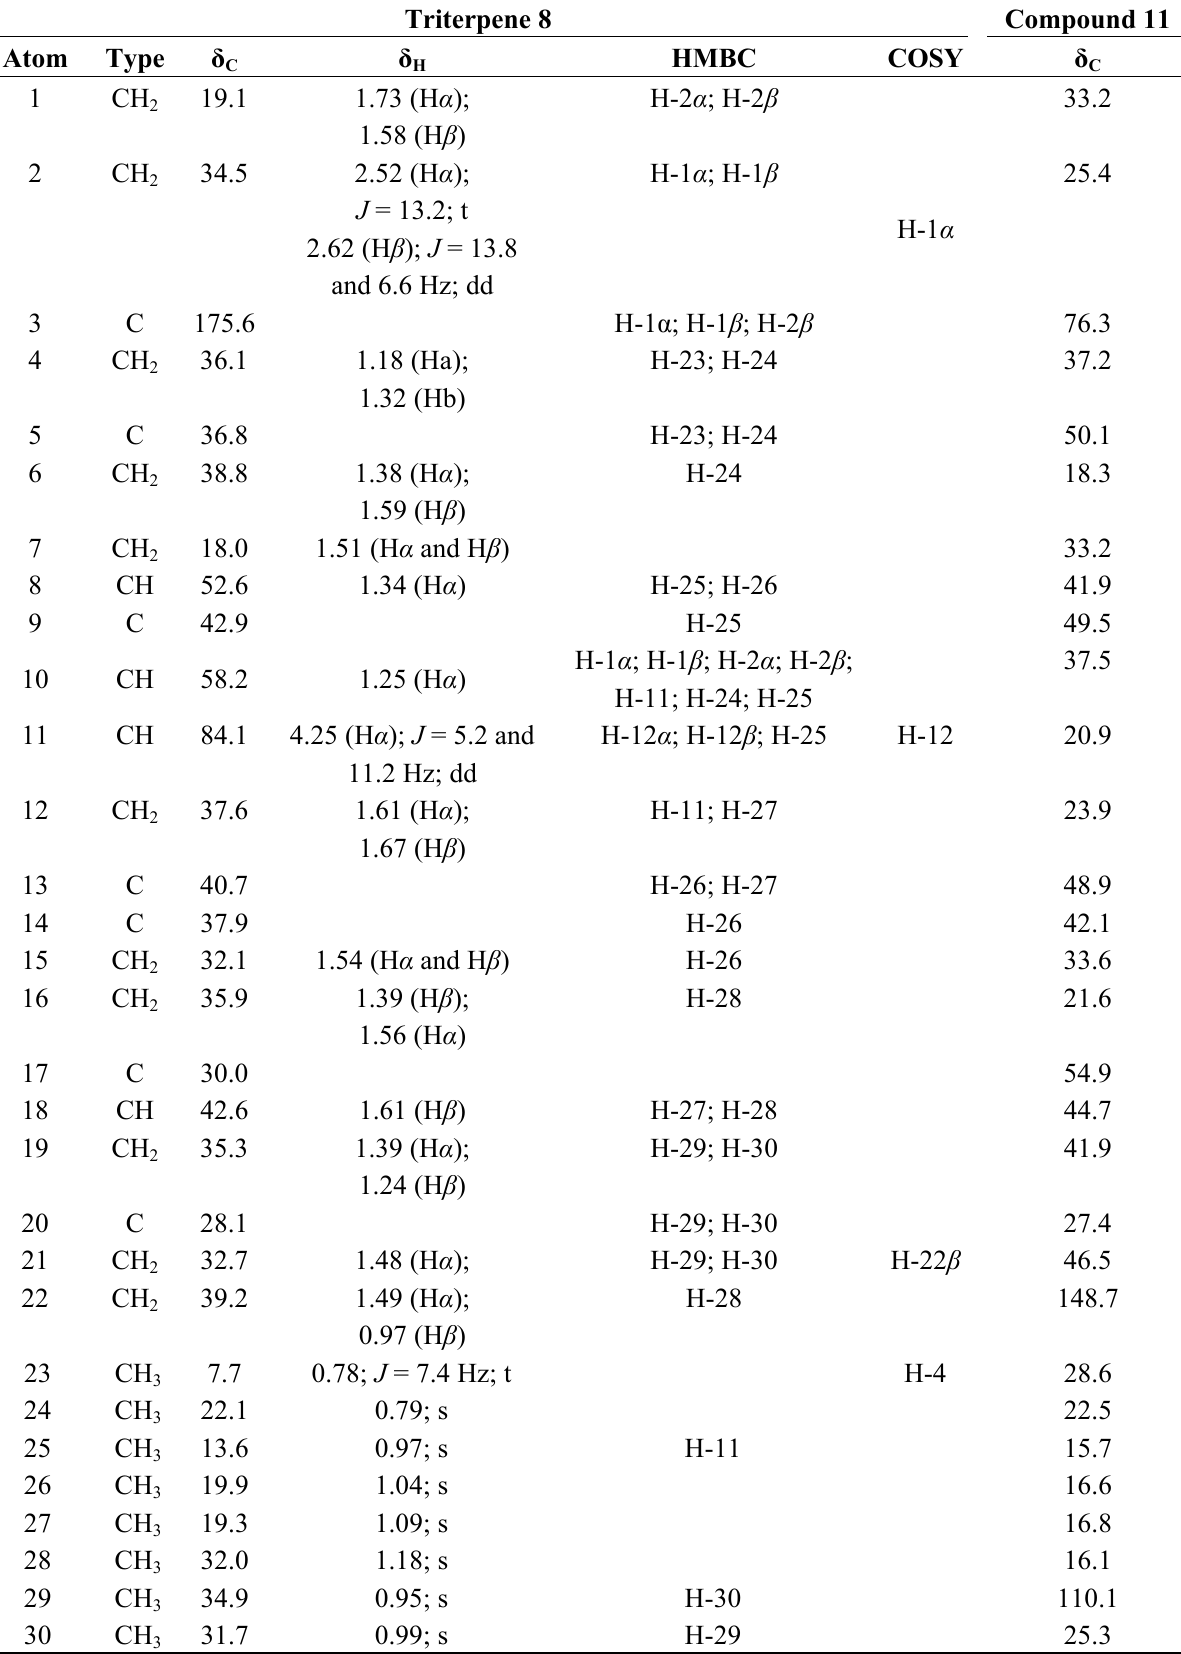
Table 2. NMR data of 8 and corresponding data described in the literature for 11 [33]. Triterpene 8 Compound